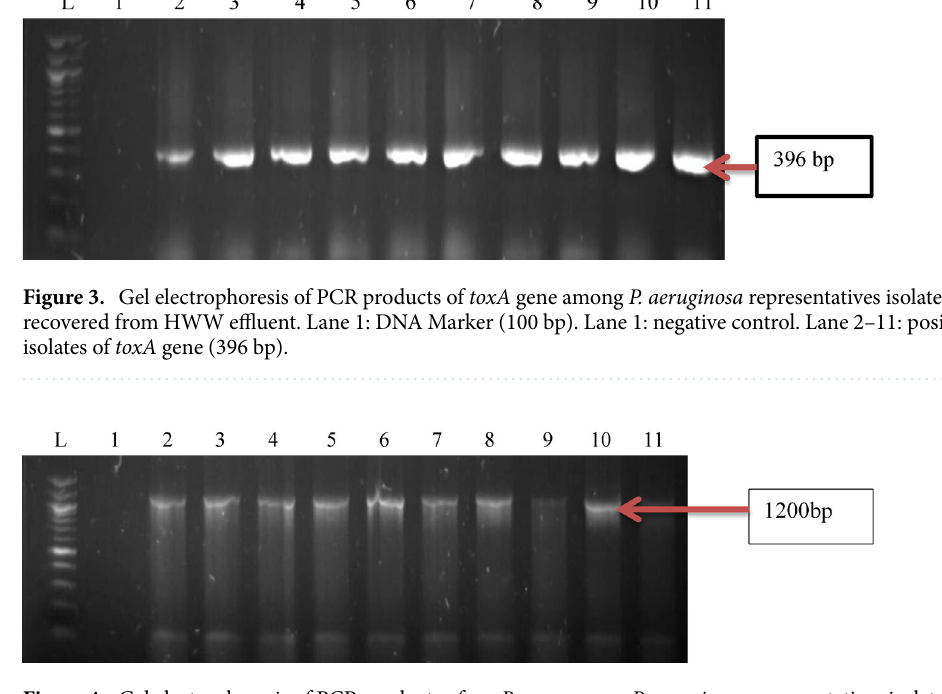
Figure 4. Gel electrophoresis of PCR products of popB gene among P. aeruginosa representatives isolates recovered from HWW effluent. Lane 1: DNA Marker (100 bp). Lane 2–11: positive isolates of popB gene (1200 bp).